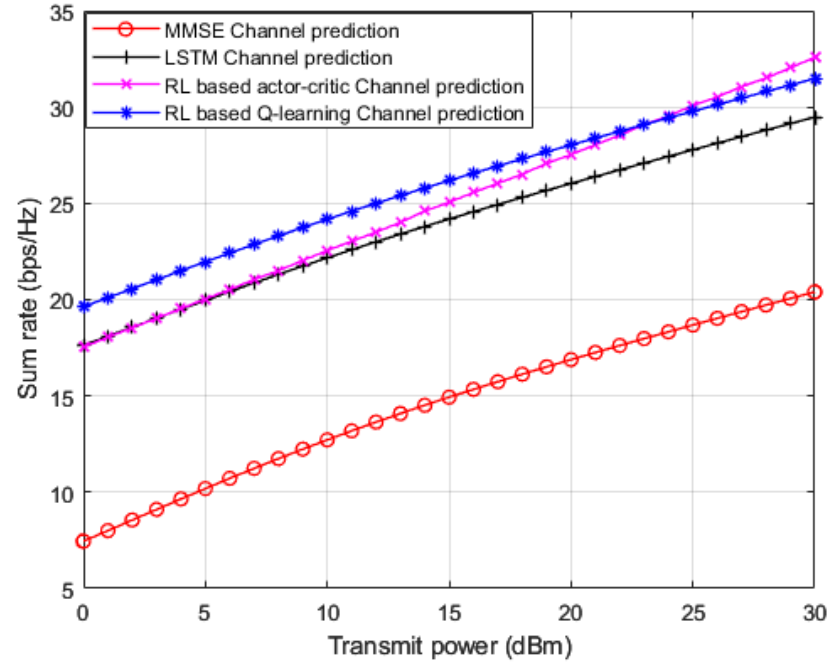
Figure 6. Sum rate vs. power (MMSE, LSTM, RL actor ‐ critic, RL Q ‐ learning).